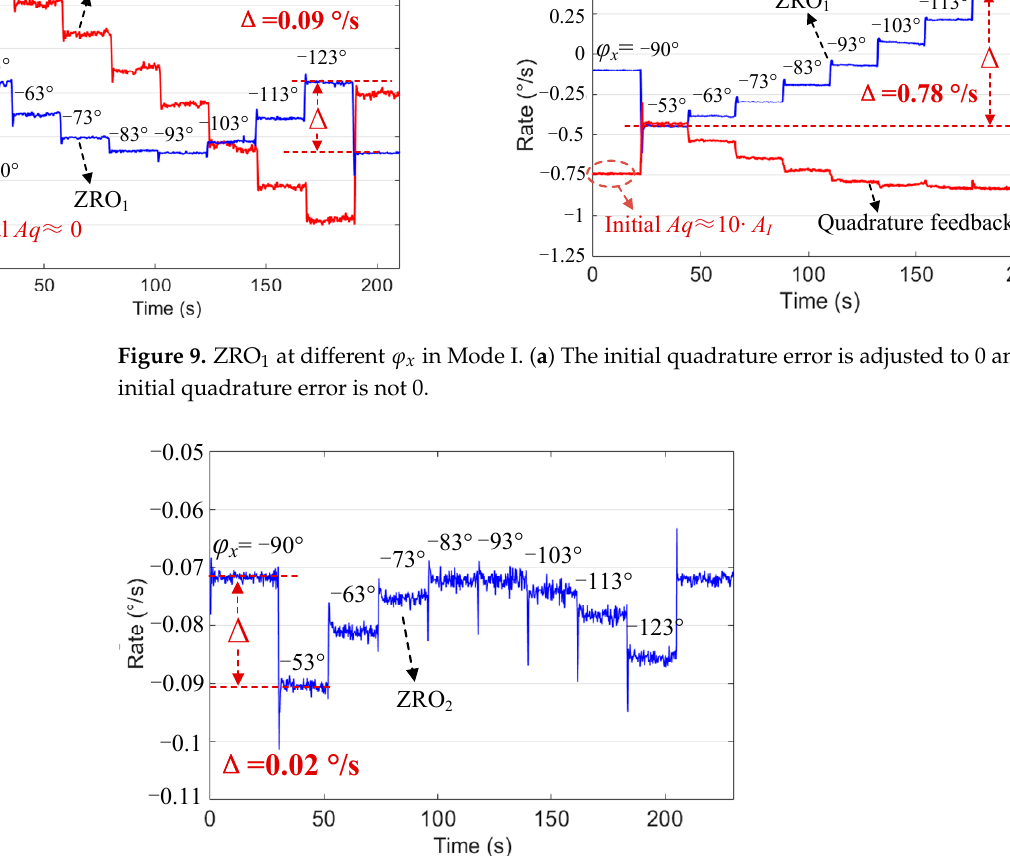
Figure 10. ZRO 2 at different ϕ x in Mode Figure 10. 2 ZRO at different x Figure 10. 2 ZRO at different